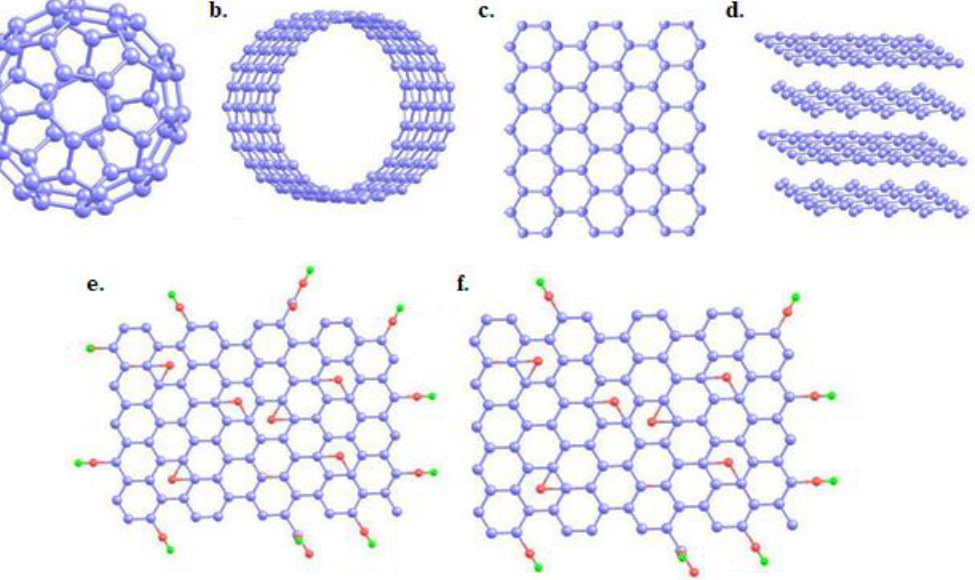
Figure 9. ( a ) 0D Fullerene, ( b ) 1D CNT, ( c ) 2D graphene, ( d ) 3D graphite structures, ( e ) GO, and ( f ) reduced GO (light purple — carbon; red — oxygen; and green — hydrogen).